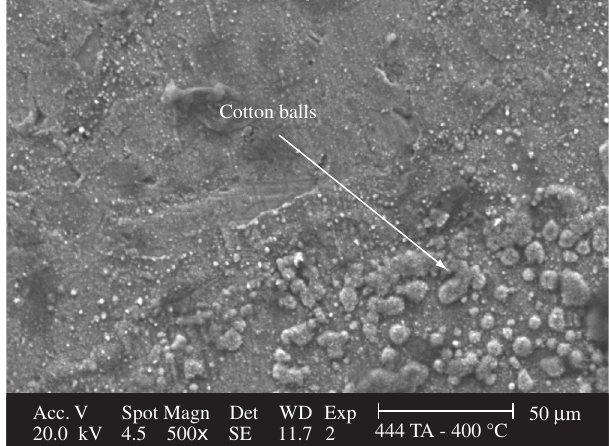
Figura 12. Surface characterization by SEM of AISI 444 stainless steel sample heat treated from room temperature up to 400 °C.